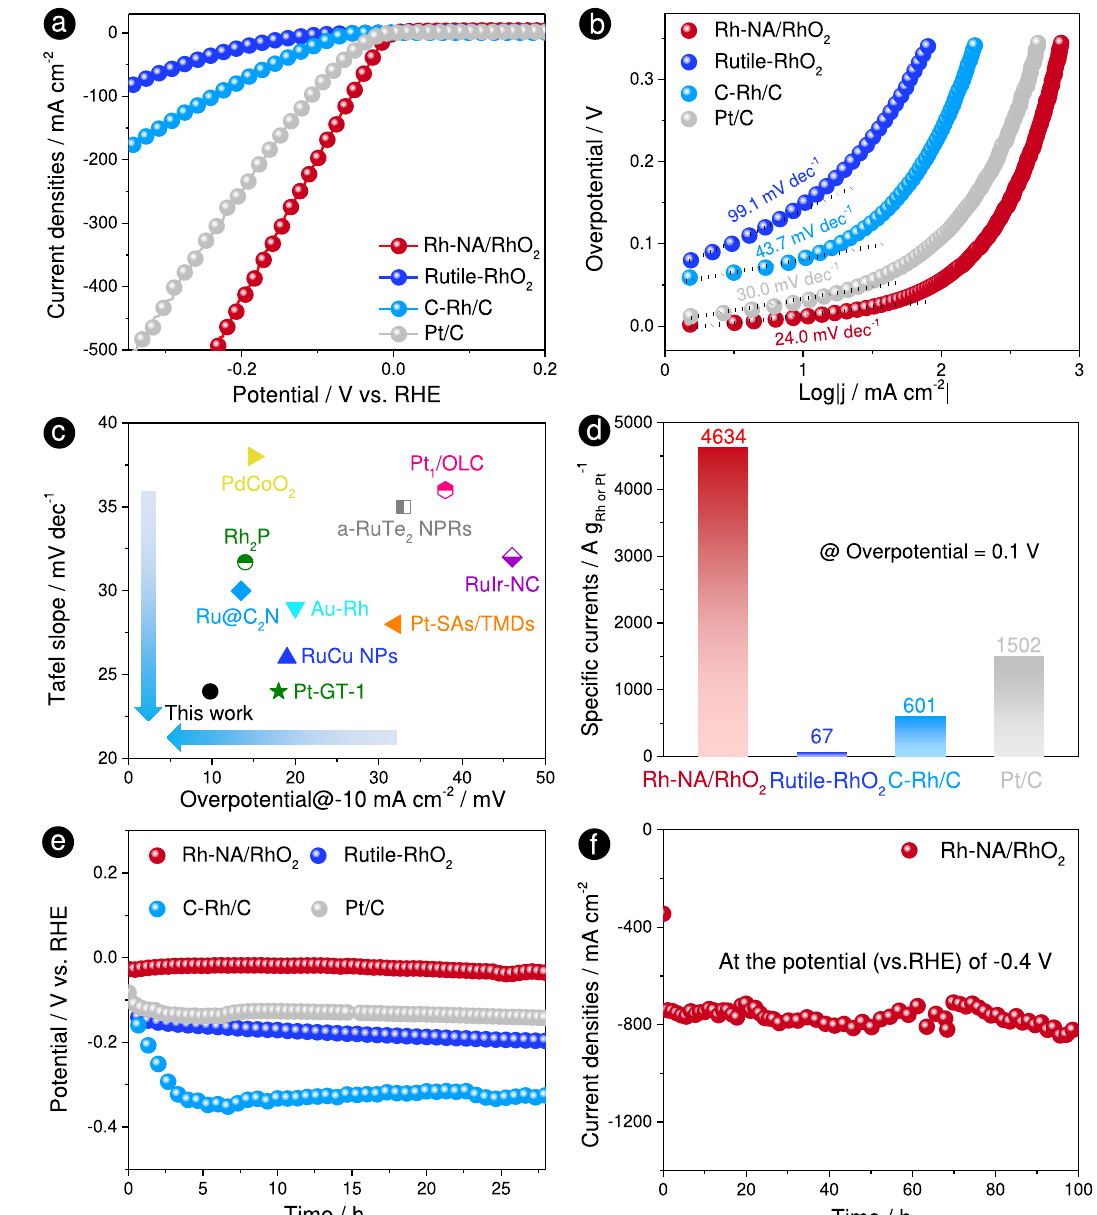
Fig. 3 | HER performances of Rh-NA/RhO 2 , Rutile-RhO 2 , C-Rh/C and Pt/C in H 2 - saturated 0.5M H 2 SO 4 electrolyte. a The HER polarization curves of Rh-NA/ RhO 2 , Rutile-RhO 2 , C-Rh/C and Pt/C with i R-correction. b Tafel plots obtained from the polarization curves of Rh-NA/RhO 2 , Rutile-RhO 2 , C-Rh/C and Pt/C in Fig. 3a. c Comparison of Tafel slopes and overpotentials at the current density of − 10mAcm − 2 for Rh-NA/RhO 2 with previous reported high activity noble metal based HER catalysts (Pt-GT-1 59 , RuCu NPs 60 , Pt-SAs/TMDs 61 , Au-Rh 62 ,